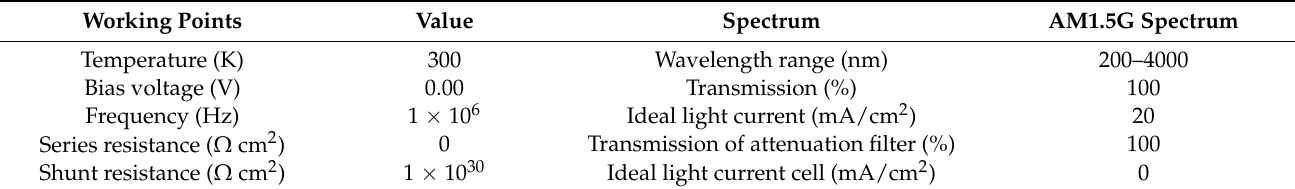
Table 1. The working points and